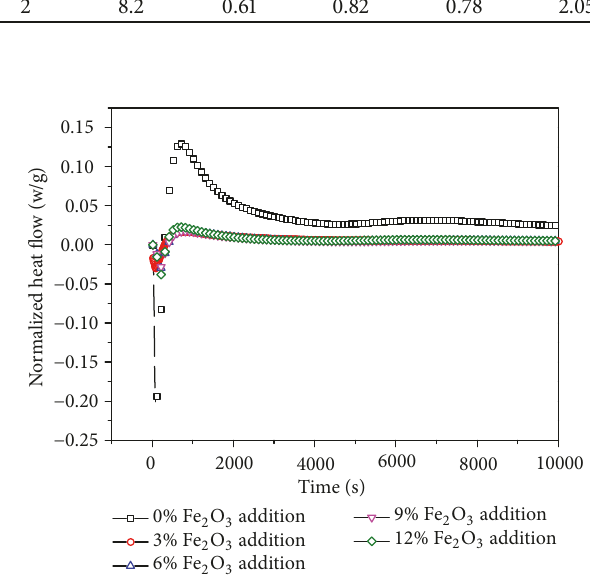
Figure 1: Exothermic curve of the mixture during